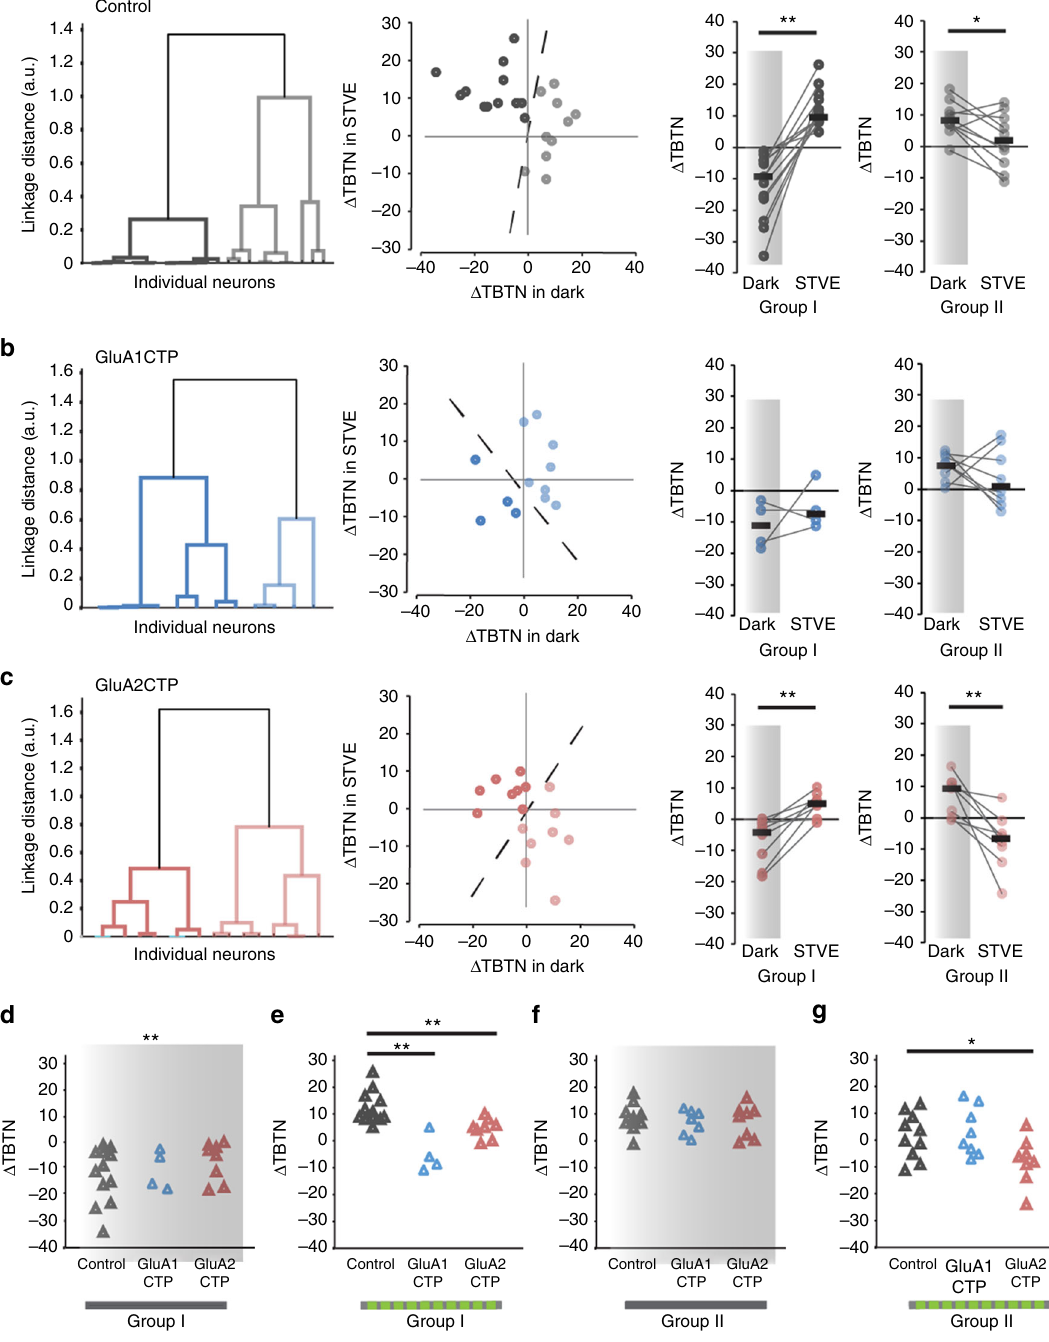
Fig. 6 Cluster analysis of experience-dependent changes in TBTN in individual excitatory neurons. a Left: Dendrogram of unsupervised hierarchical cluster analysis of control excitatory neurons based on Δ TBTN in STVE versus dark. Middle: Scatter plots of Δ TBTN in response to STVE versus dark in individual neurons for Group I and II excitatory neurons. Right: Summary of Δ TBTN in dark and STVE for Group I and II control neurons. b Cluster analysis of GluA1CTP-expressing excitatory neurons. c Cluster analysis of GluA2CTP-expressing excitatory neurons. * P < 0.05, ** P < 0.01, Wilcoxon sign rank test. d - g Summary data of Δ TBTN in response to dark ( d , f ) and STVE ( e , g ) in group I ( d , e ) and group II ( f , g ) excitatory neurons. * P < 0.05, Kruskal – Wallis test with post hoc Mann – Whitney U